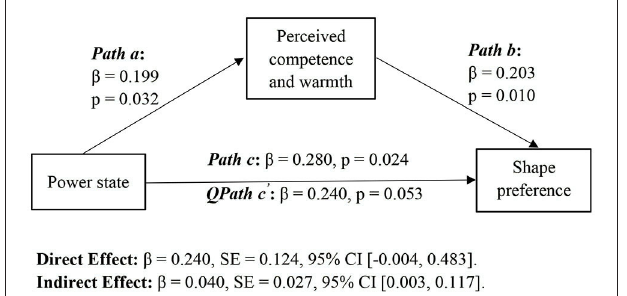
FIGURE 1 | Mediation analyses. * p < 0.05, ** p < 0.01, *** p <